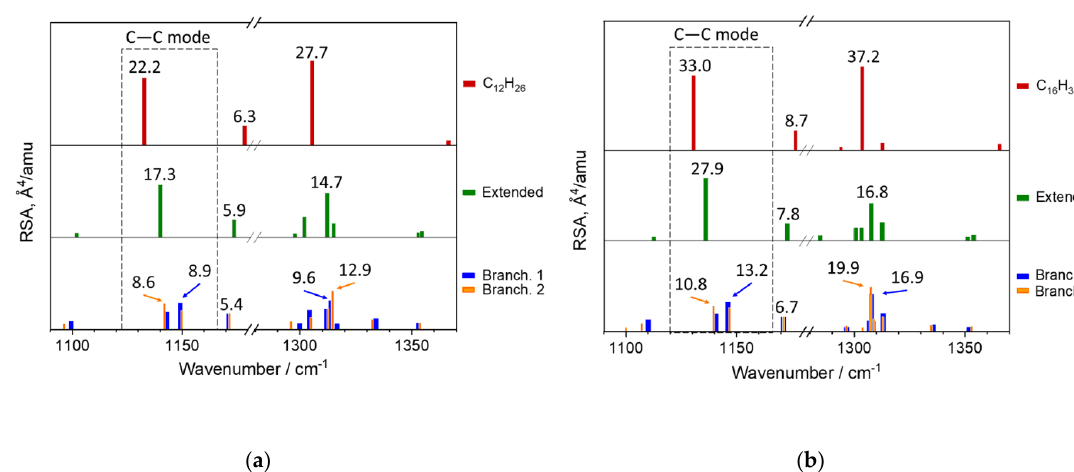
Figure 9. DFT calculated Raman spectra of molecules in di ff erent conformations (the extended, branched 1 and 2 chain conformations): linear alkane C 12 H 26 ( a ) and H2H ( a ), linear alkane C 16 H 34 and O2H ( b ) in the region 1100–1360 cm − 1